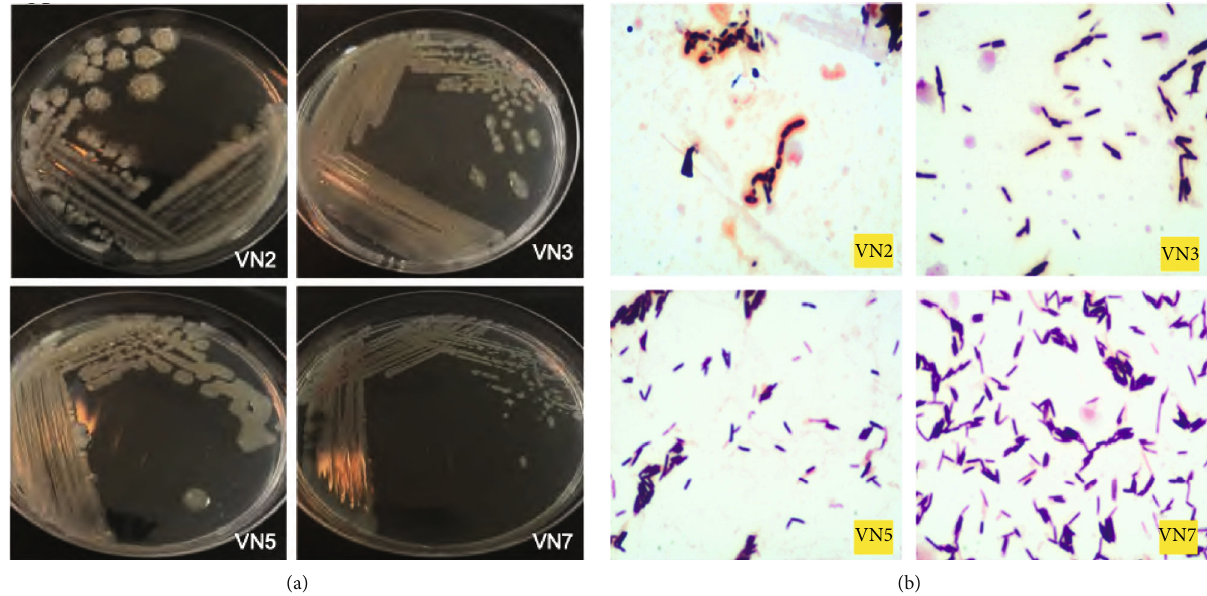
Figure 1: (a) Colony of VN2, VN3, VN5, and VN7. (b) Microscope image of rod shapes of VN2, VN3, VN5, and VN7. Table 1: The accession number of VN2, VN3, VN5, and VN7. Colony